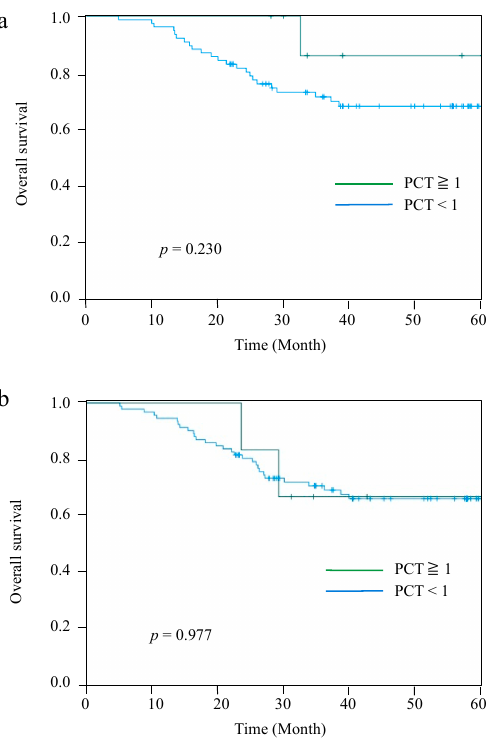
Figure 3. Kaplan–Meier curves for OS between the PCT-High group and PCT-Low group at 4 POD ( a ), and 7 POD ( b ).